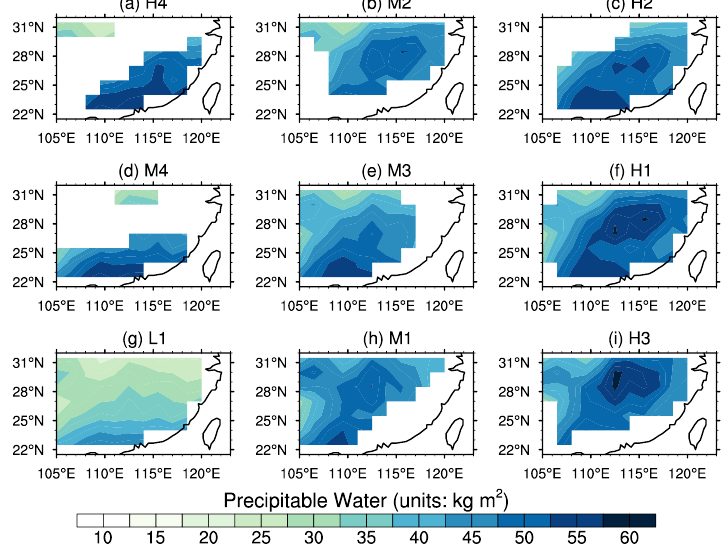
Figure 9. ( a – i ) Composite means of precipitable water (units: kgm 2 ) for the nine regimes during AMJ 1979–2015. Only composite means that pass the 95% confidence level based on two-sided Student’s t test against the complementary set of samples are